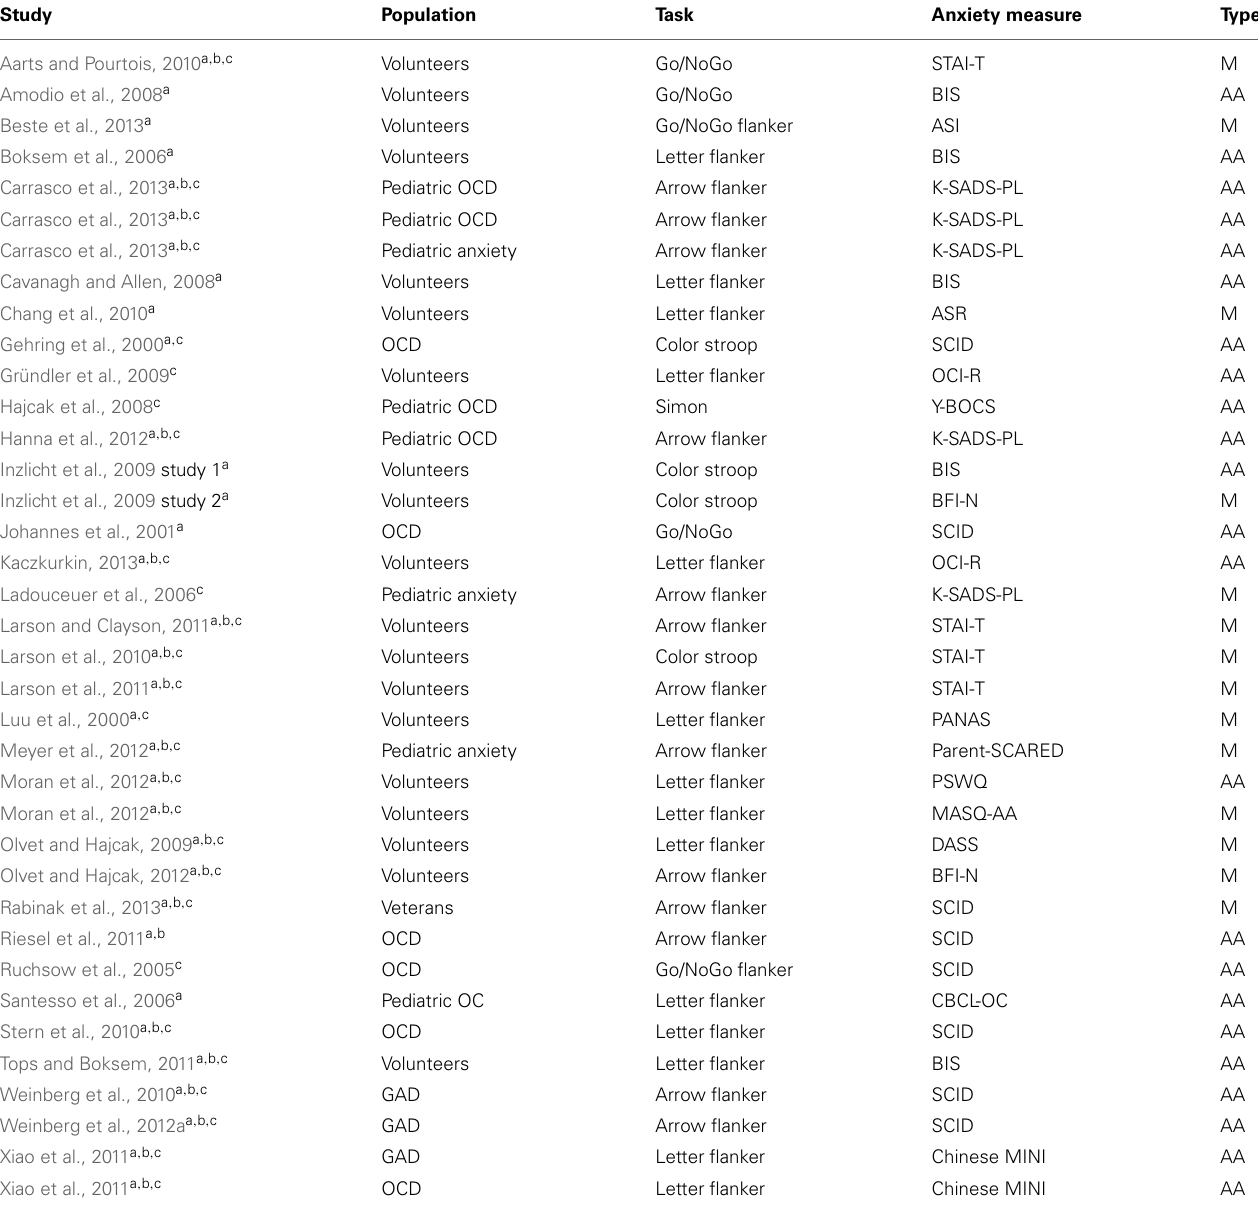
Table 1 | Characteristics of studies included in the